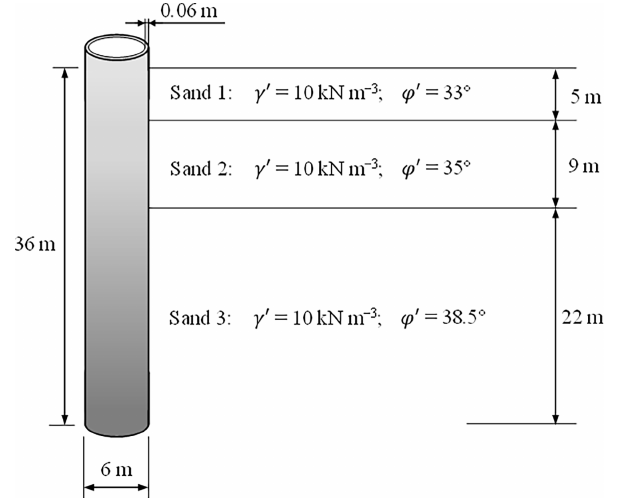
Figure 9. Soil profile and pile dimensions.